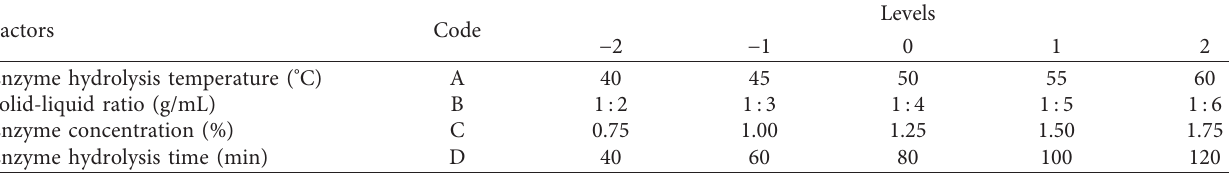
Table 1: Levels of response surface